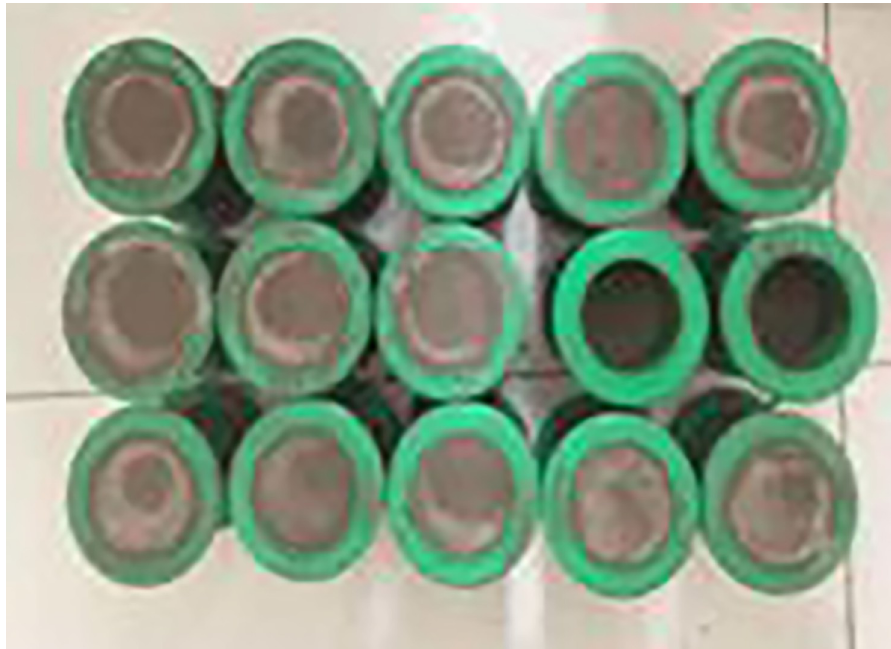
Fig 9. Sample preparation of similar materials covered by the